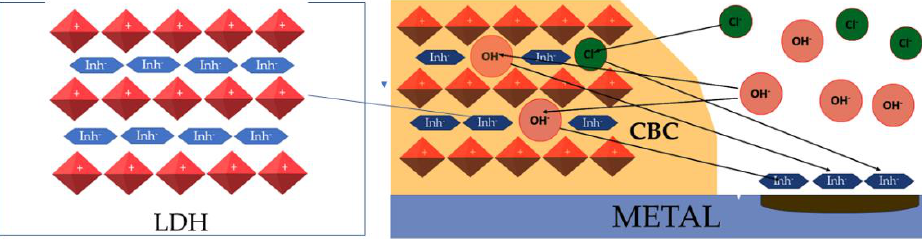
Figure 21. LDH nanocontainers act as a storage facility for inhibitors.